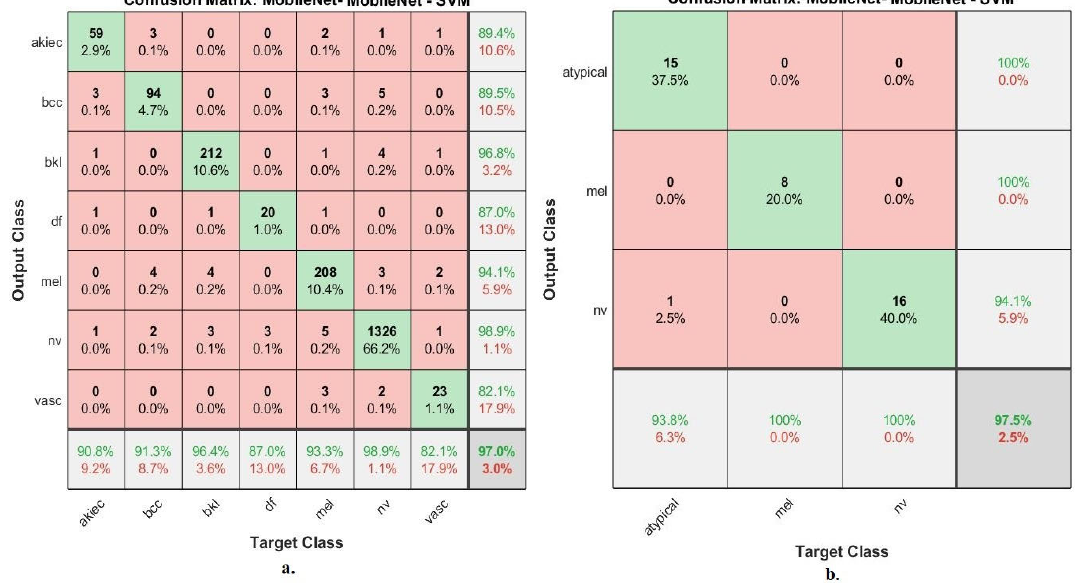
Figure 13. Confusion matrix for the classification of two skin lesion datasets by SVM with fused features of ResNet101 and ResNet101 through datasets of ( a ) HAM10000 and ( b ) PH2. Table 7. Performance of SVM with fused features of MobileNet and ResNet101 for dermoscopic image analysis to classify HAM10000 and PH2 dataset skin lesions.